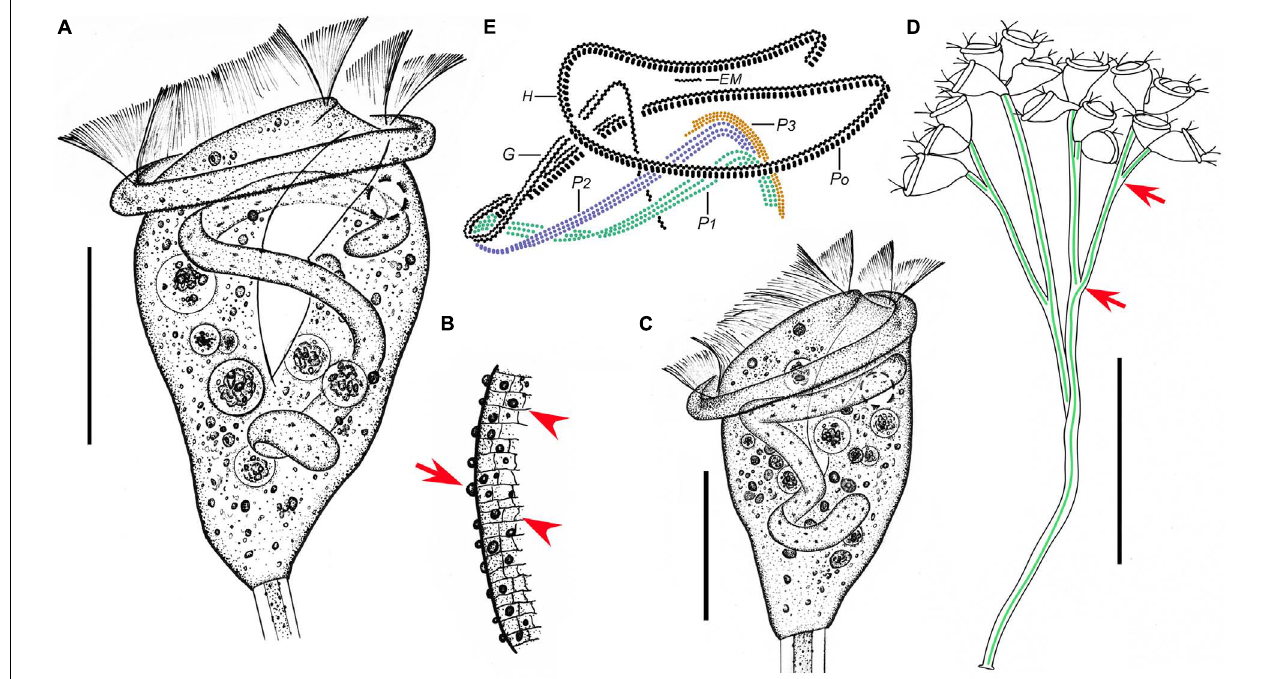
FIGURE 8 | Epicarchesium sinense n. sp. in vivo (A–D) and after protargol staining (E) . (A,C) Different zooids showing the shape variation. (B) Detail of the pellicle; arrow marks a tubercle on the surface, and arrowheads mark the reticulate pattern. (D) A mature colony; arrows mark the discontinuous spasmoneme (in green). (E) Oral ciliature. EM, epistomial membrane; G, germinal kinety; H, haplokinety; Po, polykinety; P1–3, infundibular polykineties 1–3. Bars: 30 µ m in panels (A,C) and 250 µ m in panel (D) .